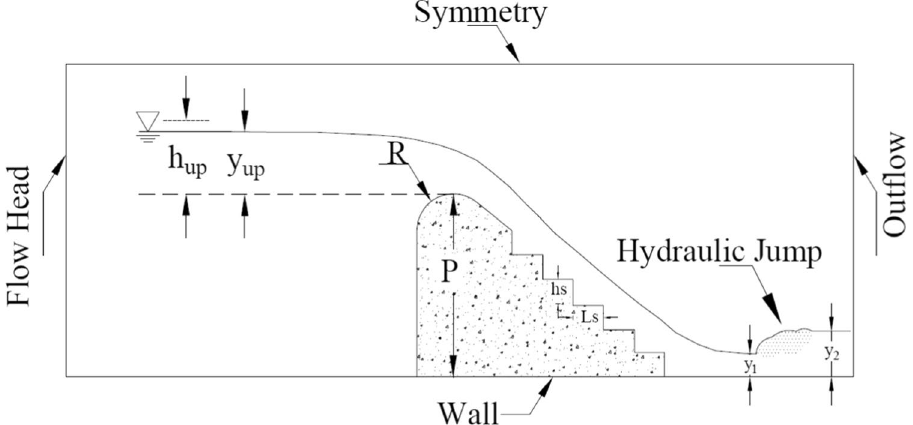
Fig. 1 The sketch of the stepped spillway with circular